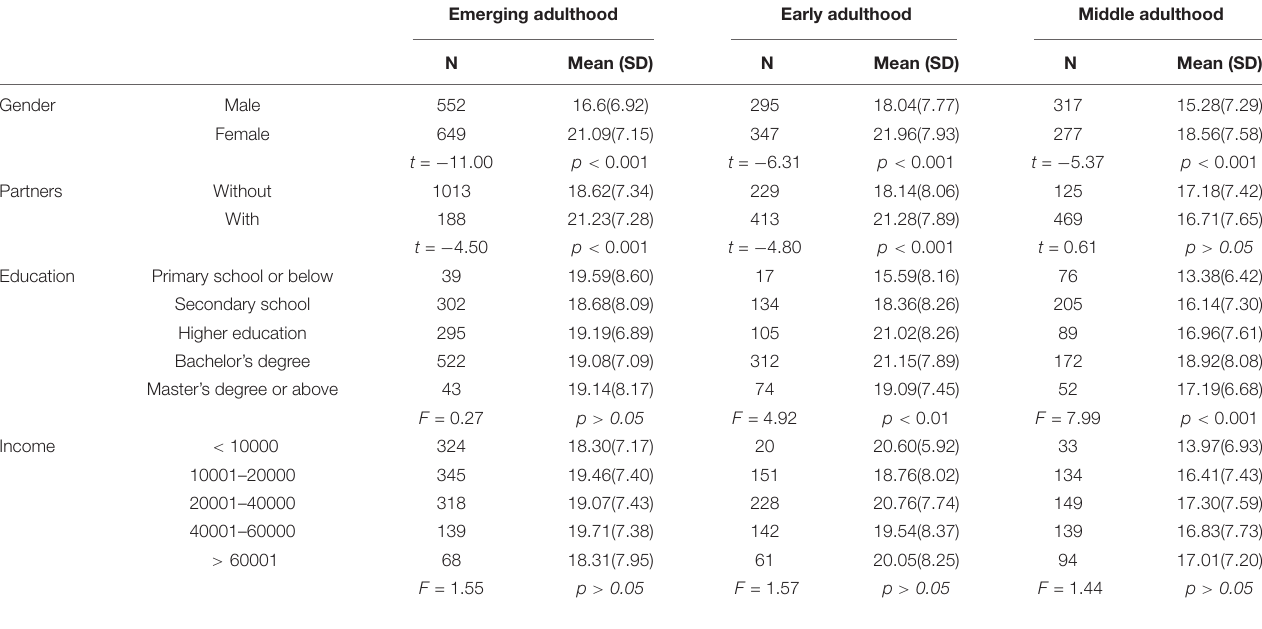
TABLE 1 | Sample demographics and means of compulsive buying by age